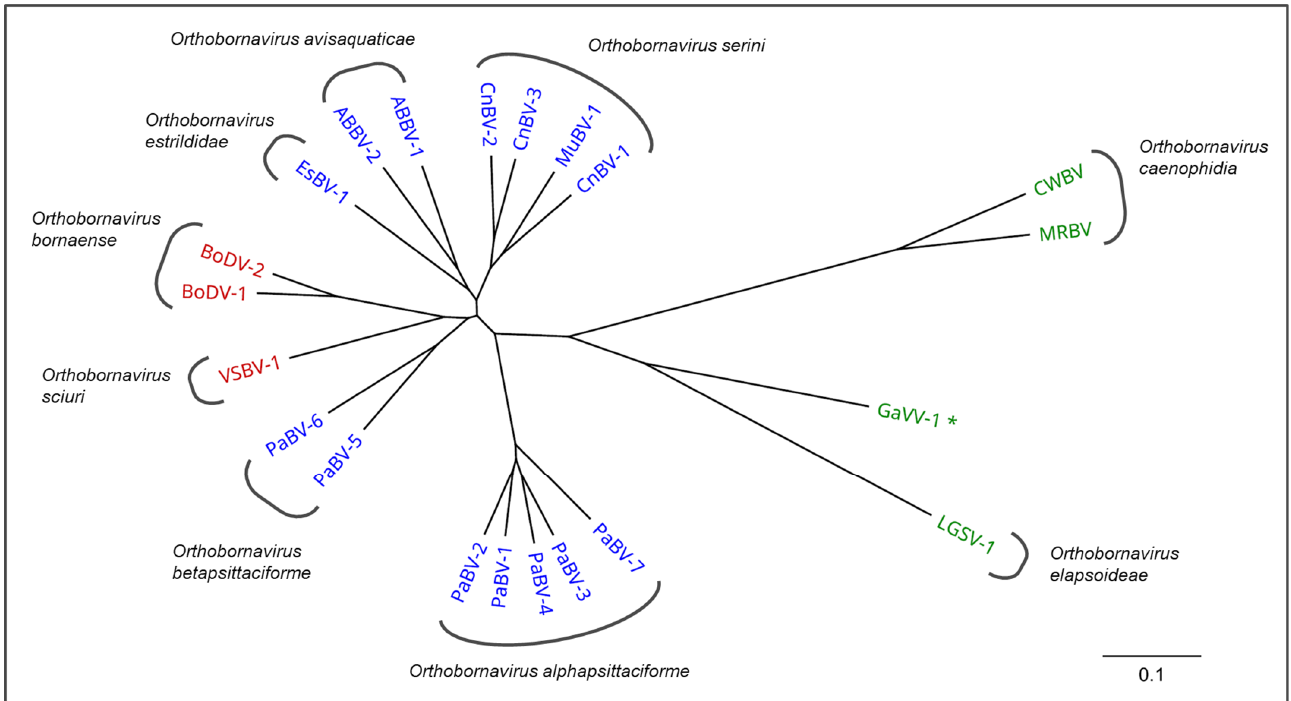
Figure 1. Phylogeny of the genus Orthobornavirus . Complete P gene sequences (606 nucleotides) of representative bornavirus sequences from birds (blue), mammals (red) and reptiles (green) were analyzed using neighbor-joining algorithm and Jukes–Cantor distance model in Geneious R11 software. Values at branches represent support in 1000 bootstrap replicates. Only bootstrap values ≥ 70 at major branches are shown. * GaVV-1 has not been classified by the International Committee on Taxonomy of Viruses (ICTV) yet. ABBV: aquatic bird bornavirus, BoDV: Borna disease virus, CnBV: canary bornavirus, EsBV: estrildid finch bornavirus, GaVV: Gabon viper virus, LGSV: Loveridge´s garter snake virus, MuBV: munia bornavirus, PaBV: parrot bornavirus, VSBV: variegated squirrel bornavirus.